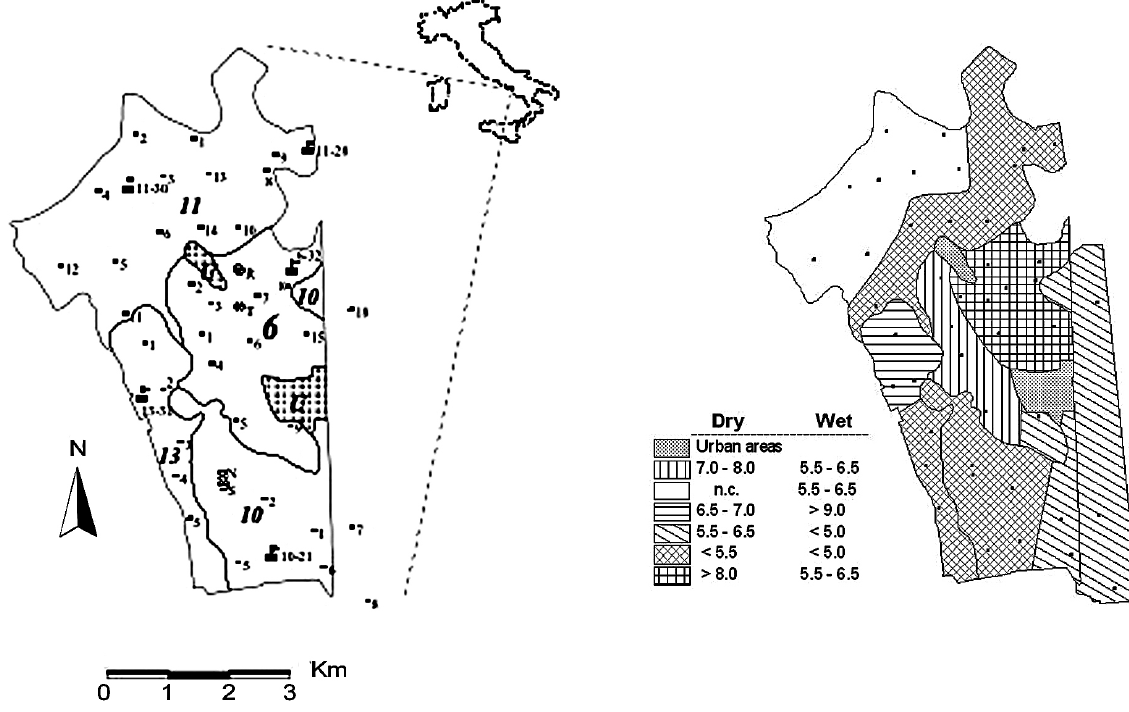
Fig. 3. Case study 2: (a) soil map and (b) hydrological functional units classified on the basis of the “functional property” d 800